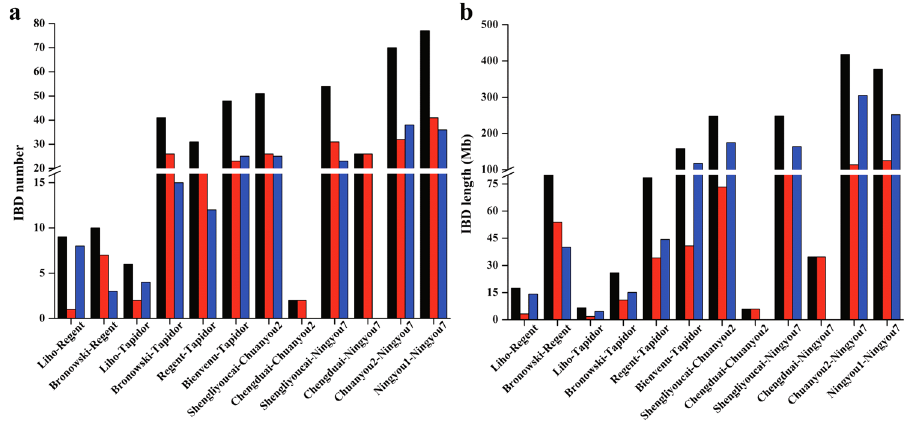
Figure 2. The number and length of identity by descent (IBD) blocks revealing the transfer of haplotype segments in the Tapidor and Ningyou7 pedigree cultivars. Number ( a ) and length ( b ) of IBD in the A and C sub-genomes of cultivars in the Tapidor and Ningyou7 pedigrees. The transfer of IBD from each progenitor to cultivars Regent, Tapidor, Chuanyou2 or Ningyou7 in the whole genome (black), A subgenome (red) and C subgenome (blue) are